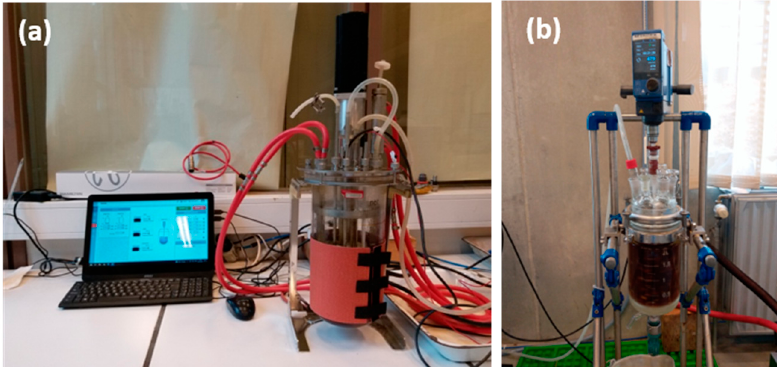
Figure 1. View of bio-fermenter ( a ) and stirred tank leaching reactor ( b ).